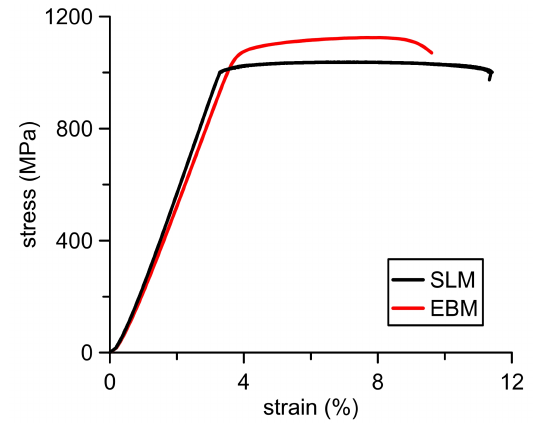
Figure 5. Exemplary stress-strain curves for EBM and SLM tensile specimens.